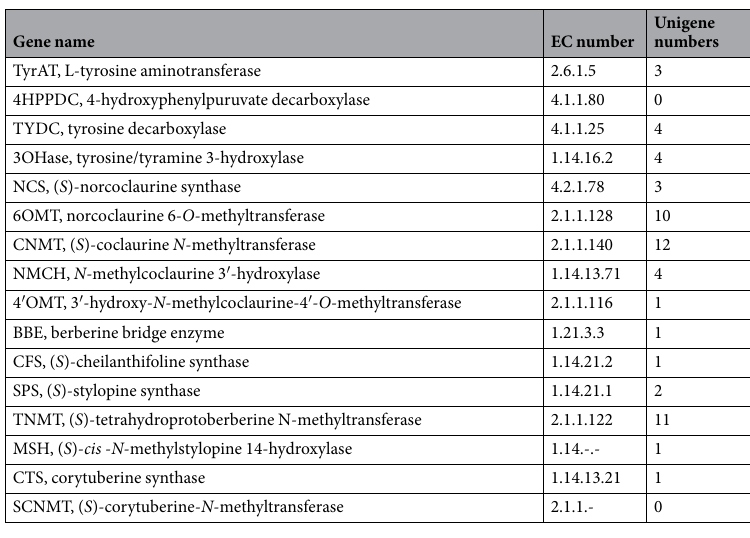
Table 3. Unigenes involved in biosynthesis of isoquinoline alkaloid.